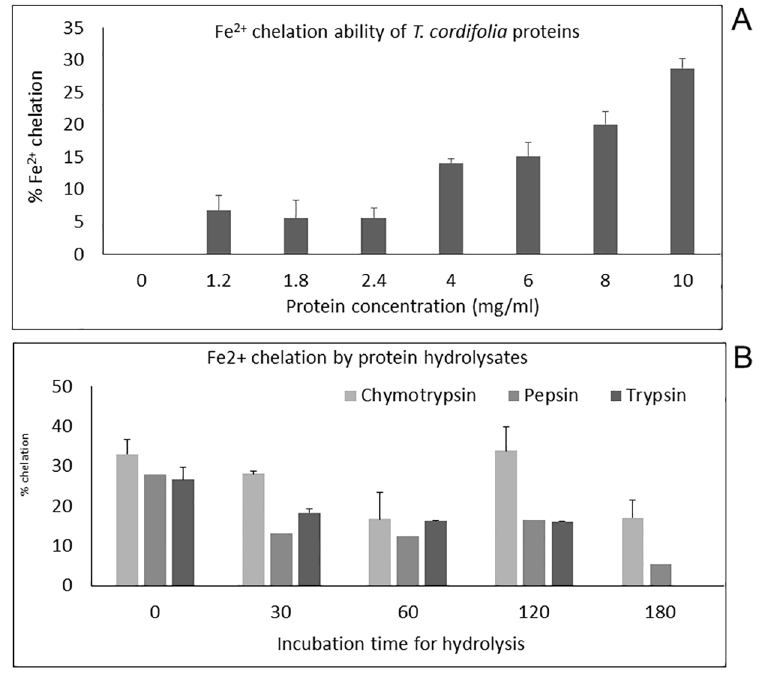
Fig 6. Fe 2+ chelating activity. (A) T . cordifolia stem proteins; (B) enzyme hydrolysates (trypsin, chymotrypsin, and pepsin) of T . cordifolia stem proteins at a concentration of 4 mg/ml for all hydrolysis